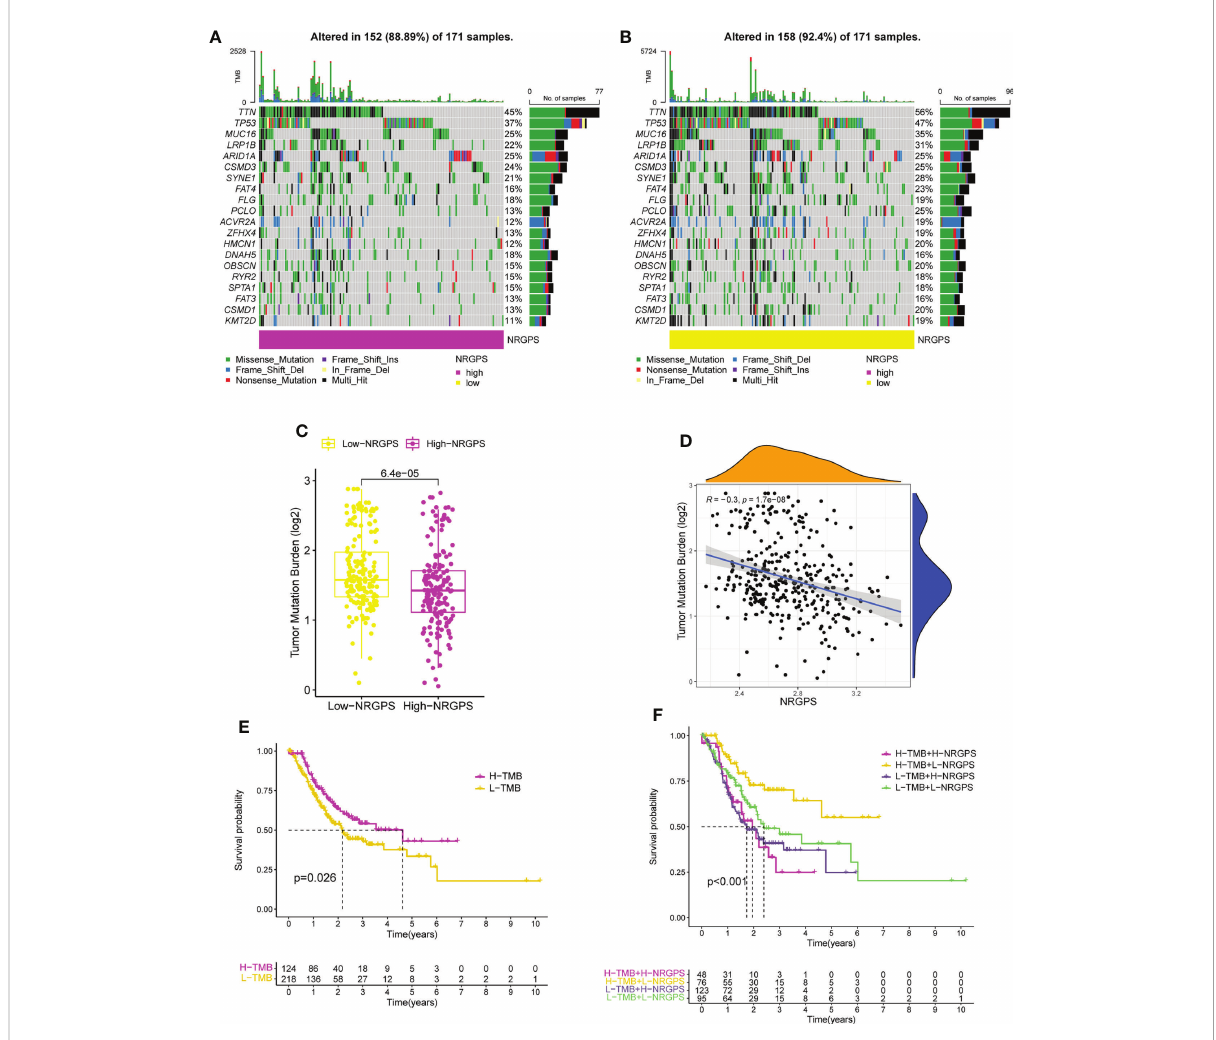
FIGURE 10 TMB analysis and survival analysis of patients in TCGA cohort. (A) The waterfall plot of somatic mutation in high-NRGPS group. (B) The waterfall plot of somatic mutation in low-NRGPS group. (C) The boxplot of TMB differences between low-NRGPS and high-NRGPS groups. (D) Correlation analysis between TMB and NRGPS. (E) Difference in survival time between high- and low-TMB groups. (F) Survival analysis of TMB combined NRGPS. TMB, Tumor mutation burden; NRGPS, necroptosis-related gene prognostic